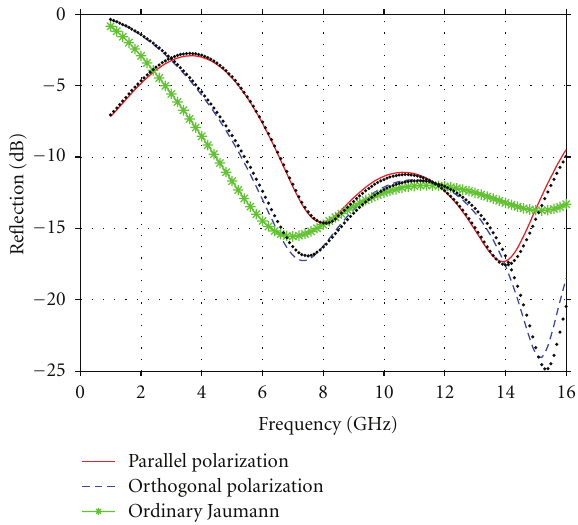
Figure 5: The reflection from the FSS-backed Jaumann absorber for the parallel (solid line) and orthogonal (dashed line) polarizations and the optimized Jaumann absorber with the same thickness (stars line) determined by the wave-splitting model. The full-wave analysis of each polarization is also shown by dotted-line curves.